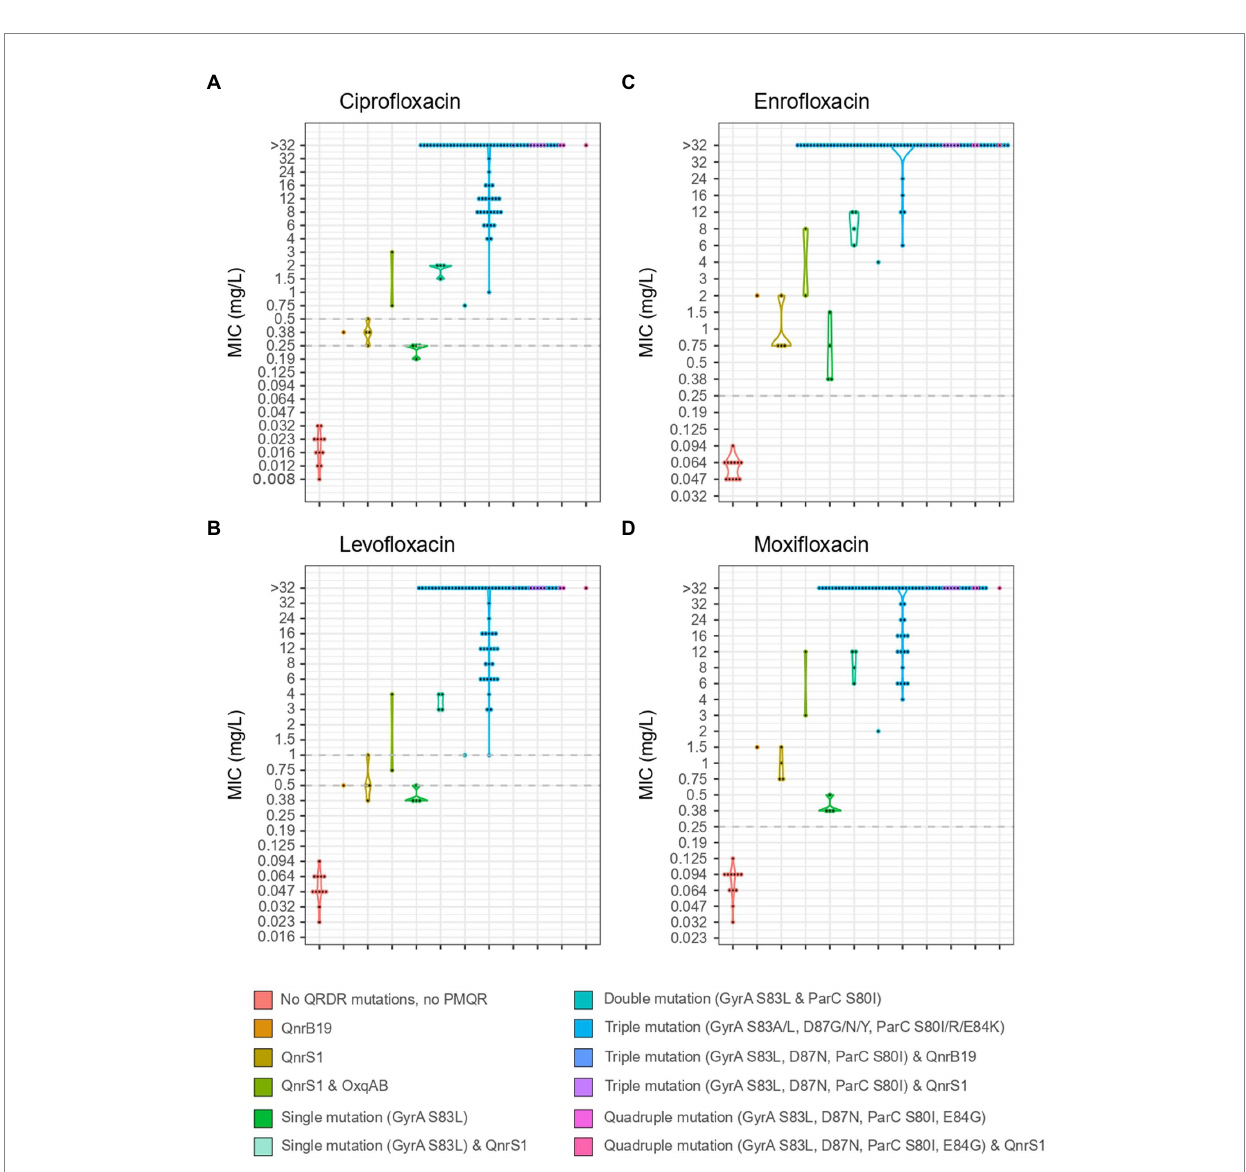
FIGURE 3 MIC values for ciprofloxacin (A) , levofloxacin (B) , enrofloxacin (C) and moxifloxacin (D) of 106 isolates from Belgian broilers and pigs in association with the mutations in QRDR regions of GyrA and ParC and the presence of PMQR genes. EUCAST breakpoints are indicated with a horizontal, dotted grey